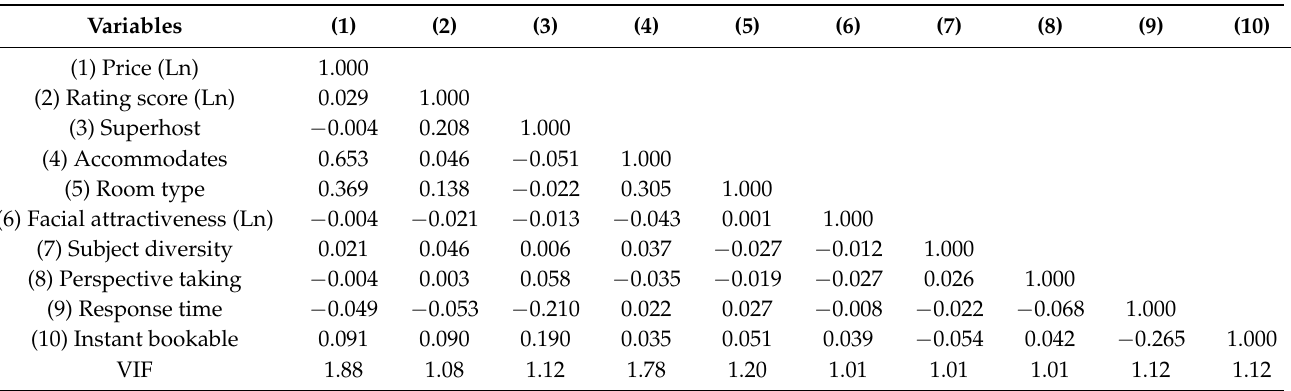
Table 4. Correlations between the